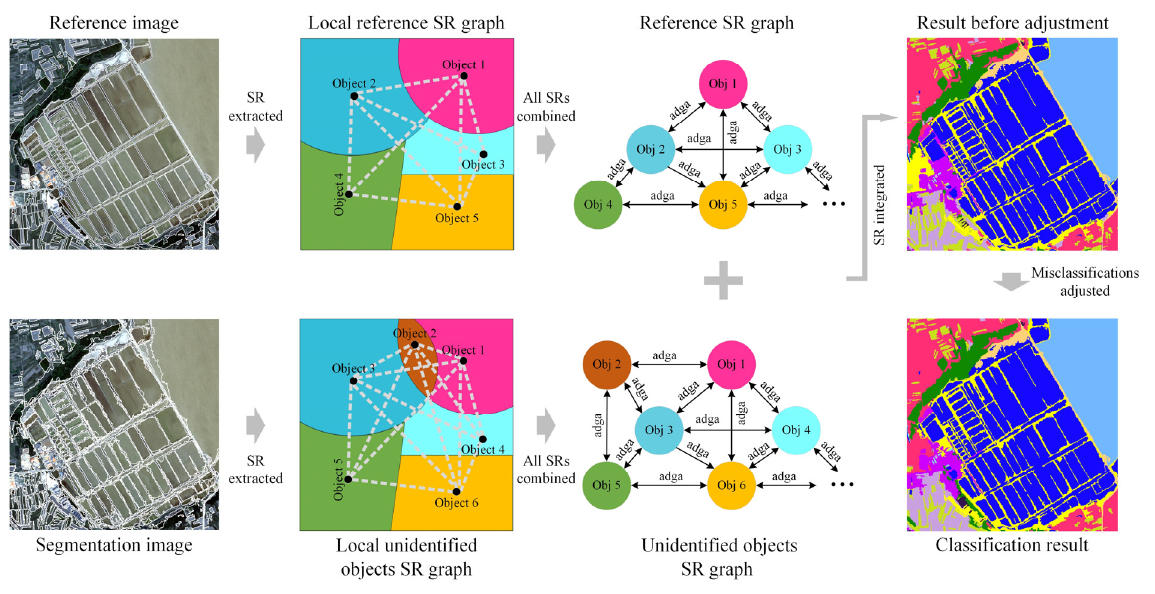
Figure 8. Process of integrating all spatial relationships. The SR represents the spatial relation and Obj represents the